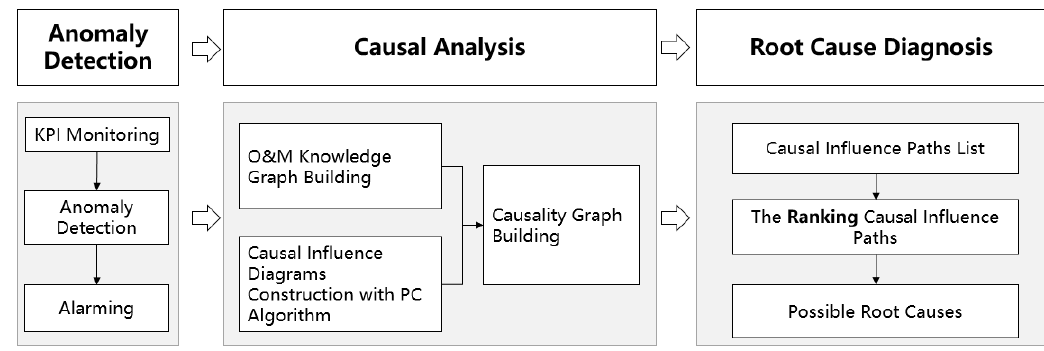
Figure 1. Framework of the proposed